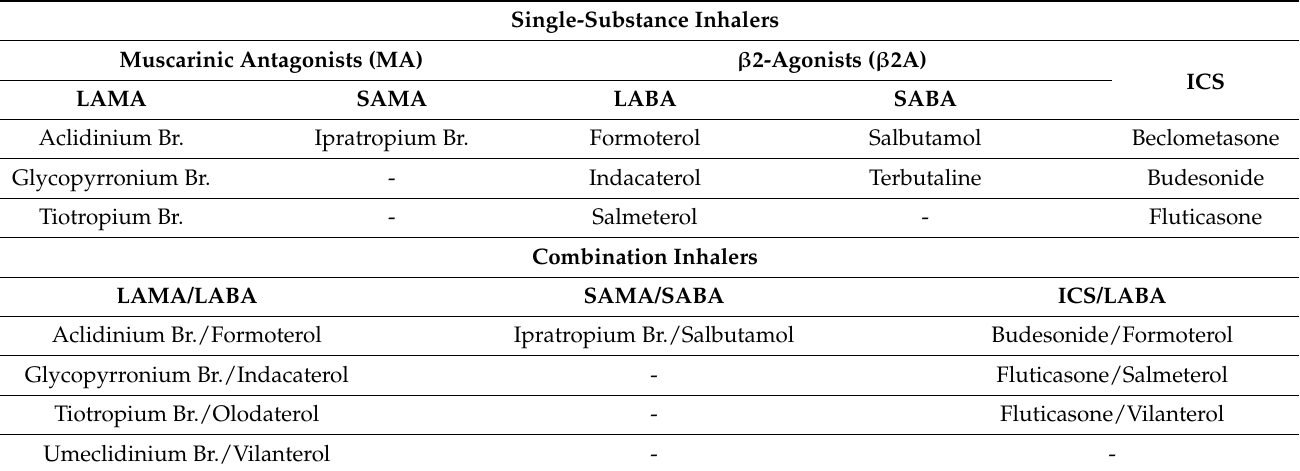
Table 1. Single-substance and combination